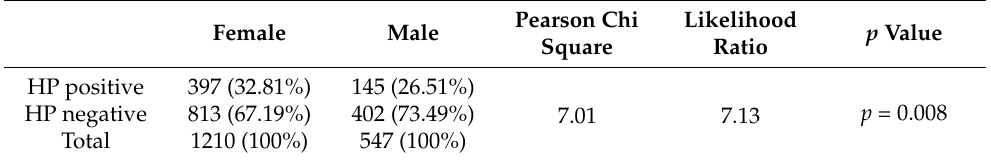
Figure 3. Structure of the batch of patients with or without H. pylori infection by gender.